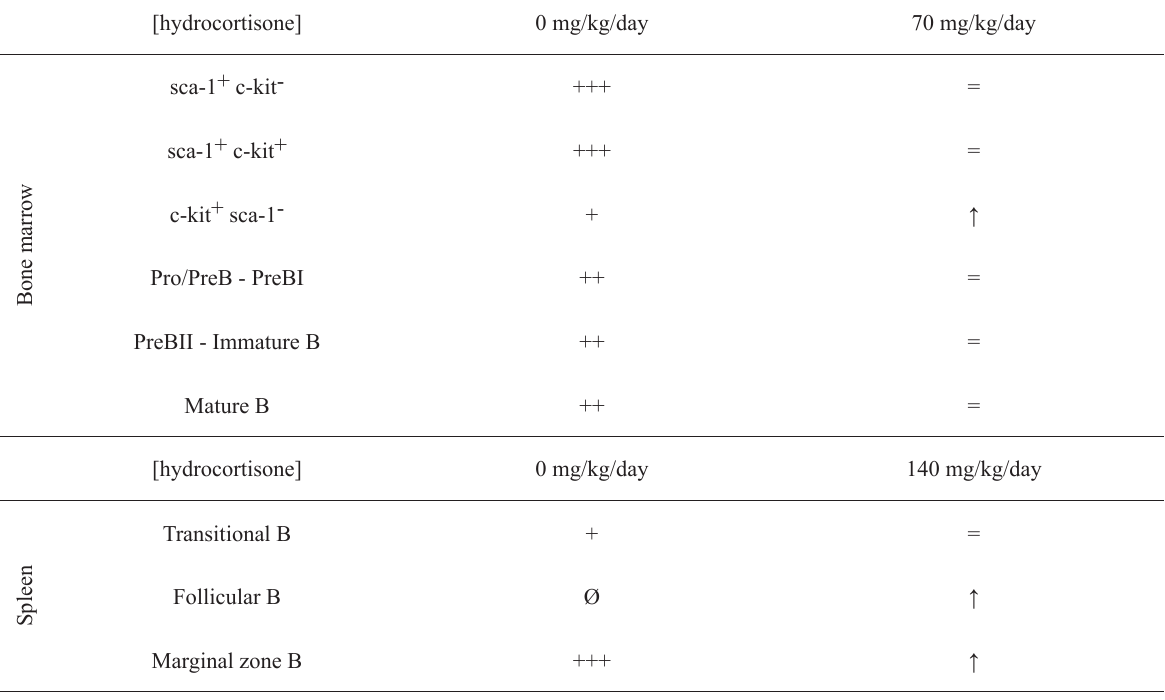
Effect of in vivo treatment with hydrocortisone on ABCB1 transport activity of B cell subsets. [hydrocortisone]